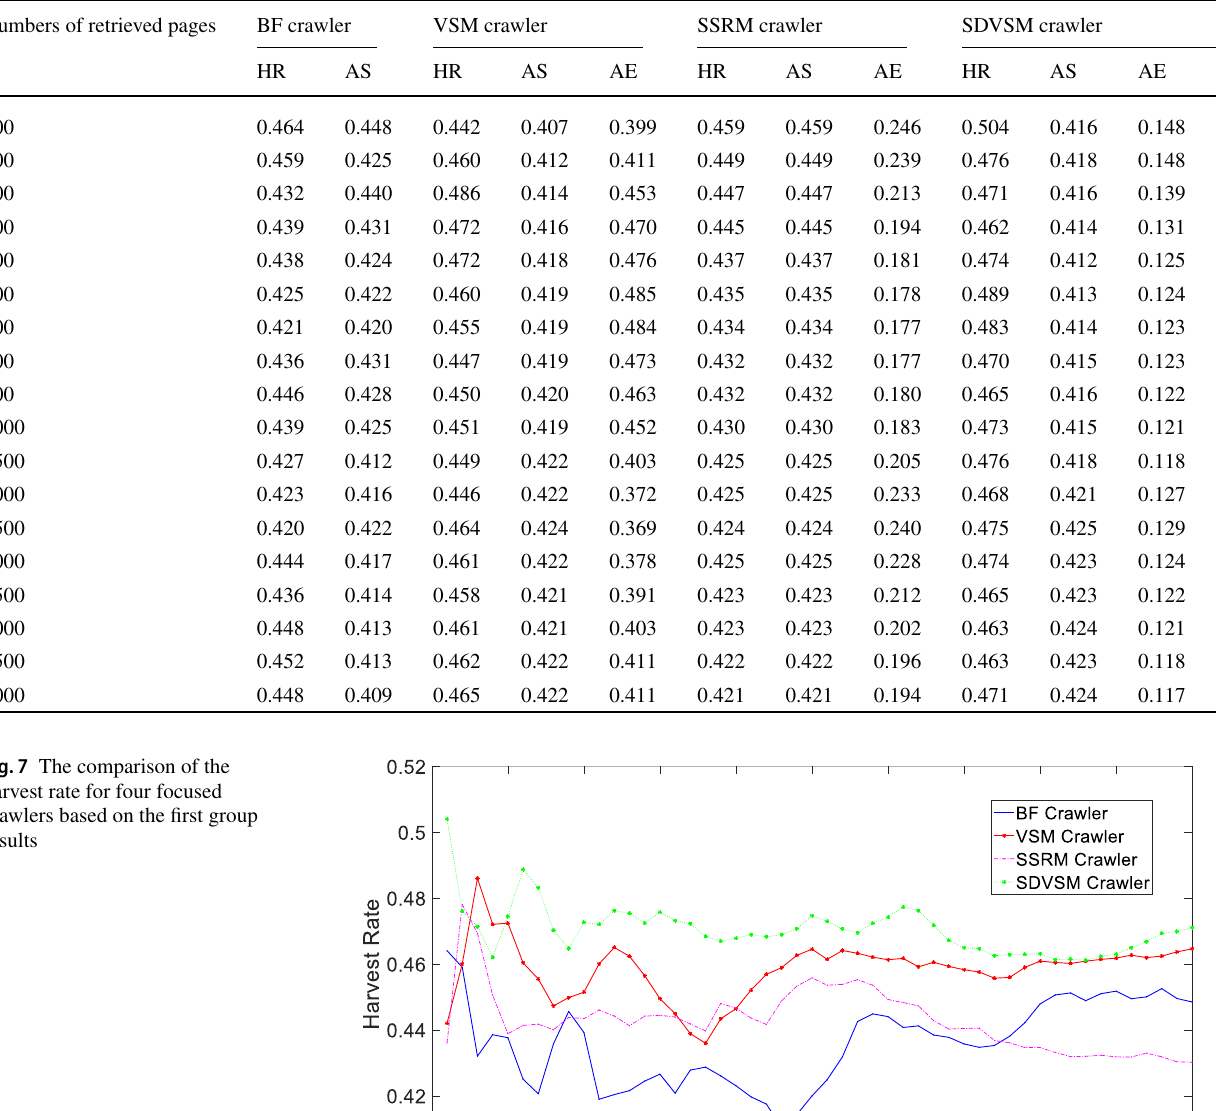
Fig. 7 The comparison of the harvest rate for four focused crawlers based on the first group